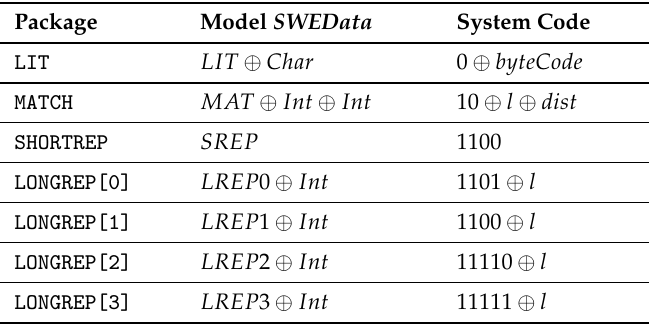
Table 4. σ sr possible token formats.